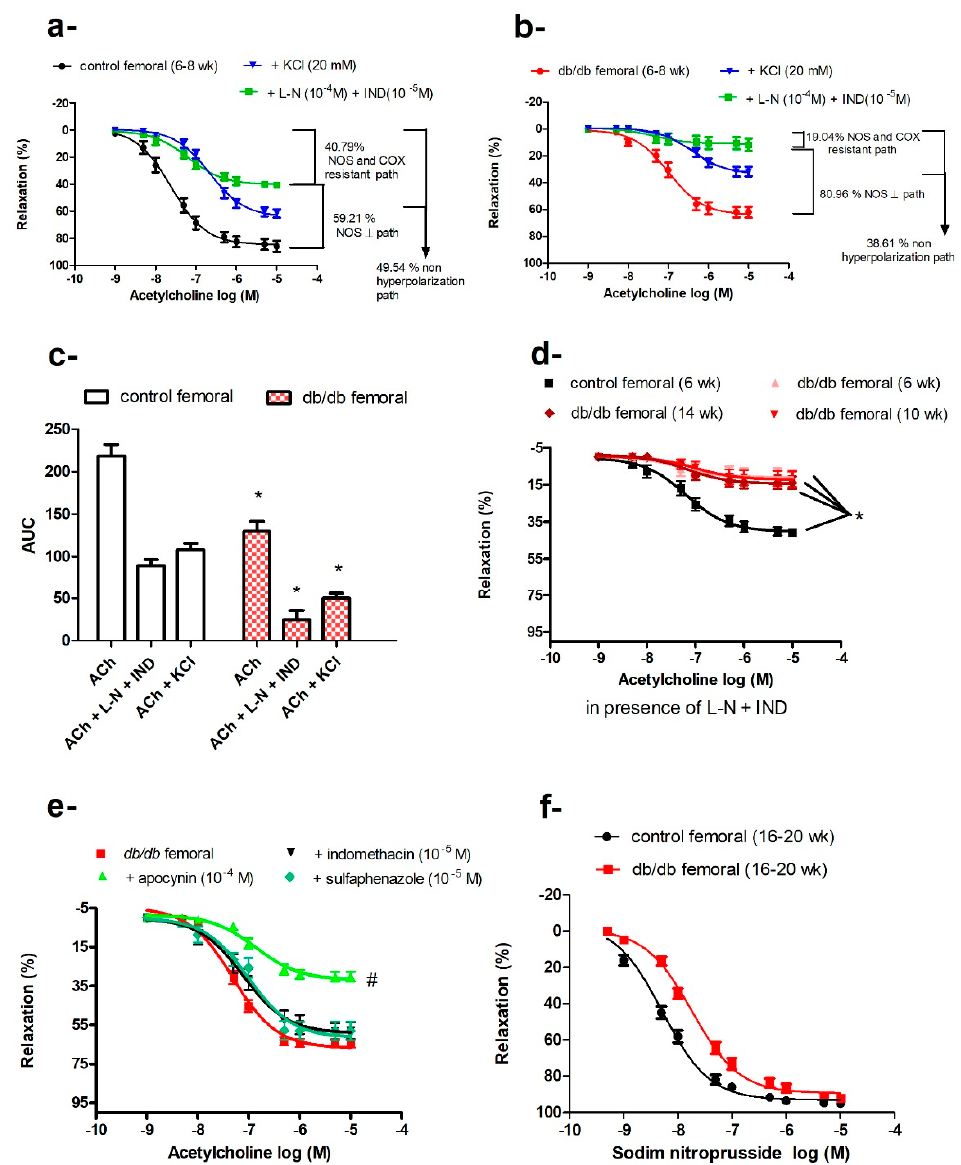
Figure 6. Impaired vasodilatation in the femoral arteries of db / db mice. Cumulative concentration– response curves of acetylcholine in the femoral arteries of control mice ( a ) and db / db mice ( b ) at 6–8 weeks old in the presence or absence of L-NAME and indomethacin or KCl ( n = 7–10). ( c ) Relative contribution of nitric oxide synthase (NOS)- and cyclooxygenase (COX)-resistant component and KCl-resistant component to acetylcholine-induced vasodilatation in control and db / db mice, as reflected by their respective area under the curve (AUC). ( d ) Cumulative concentration–response curves of acetylcholine in the presence of L-NAME and indomethacin in the femoral arteries of control and db / db mice at 6–8 weeks, 10–14 weeks, and 16–20 weeks of age ( n = 7–10 mice). ( e ) E ff ects of apocynin, indomethacin, and sulfaphenazole on acetylcholine-induced vasodilatation in the femoral arteries of db / db mice at 16–20 weeks of age ( n = 5–10 mice). ( f ) Cumulative concentration–response curves of sodium nitroprusside (SNP) in the femoral arteries of db / db at 16–20 weeks old ( n = 6–10 mice). Values are displayed as mean ± SE. Dose–response curves were compared by two-way repeated-measures ANOVA followed by Bonferroni post-test. Areas under the curve were compared by two-way ANOVA followed by Bonferroni post-test. * denotes p < 0.05 vs. control femoral, # denotes p < 0.05 vs. db / db femoral. AUC = area under the curve, COX = cyclo-oxygenase, IND = indomethacin, L-N = L-NAME, NOS = nitric oxide synthase.